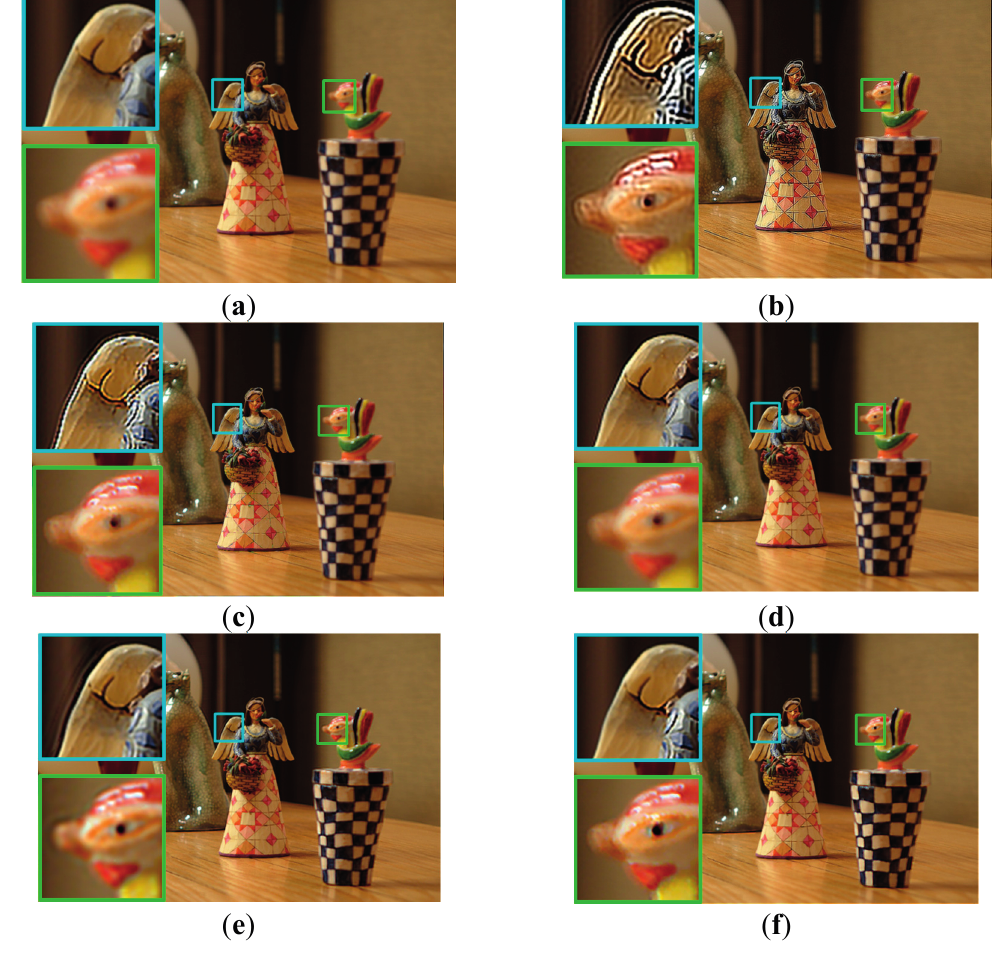
Figure 12. Comparison of different restoration algorithms using a real image with multiple objects with different distances from the camera; ( a ) the input image; ( b ) the restored image by the Dong’s method [24]; ( c ) the restored image by the Yang’s method [25]; ( d ) the restored image by the Xu’s method [12]; ( e ) the restored image by the Shen’s method [14]; and ( f ) the restored image by the proposed